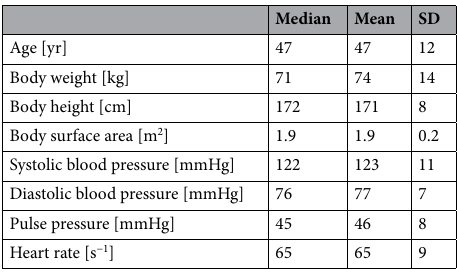
Table 1. Basic information on the participants.